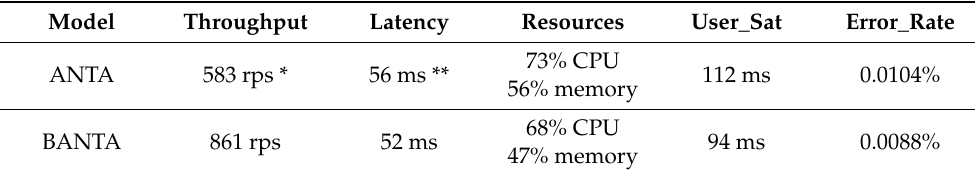
Table 3. Scalability performance metrics of the ANTA and BANTA